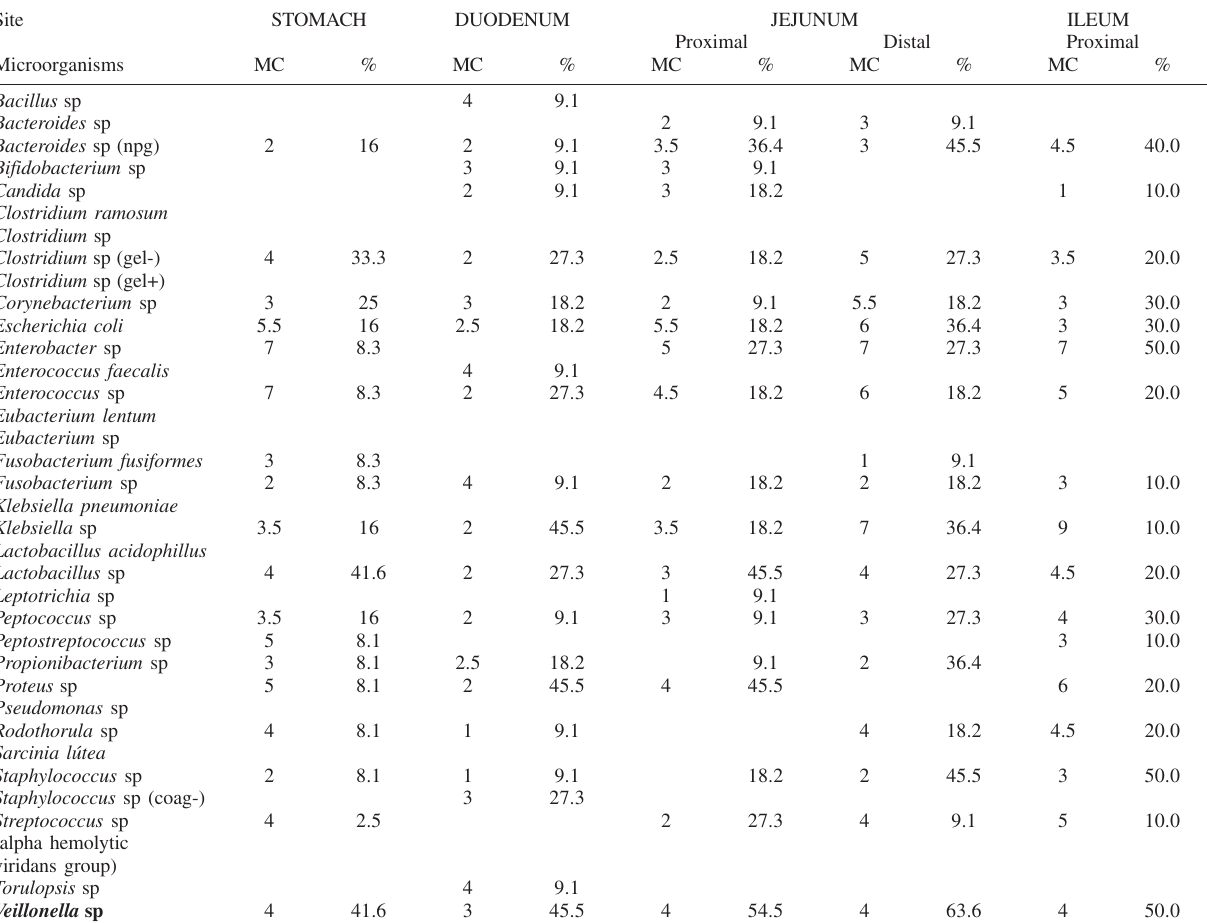
Table 3 - Mean concentration and prevalence of microorganism in the upper digestive tract